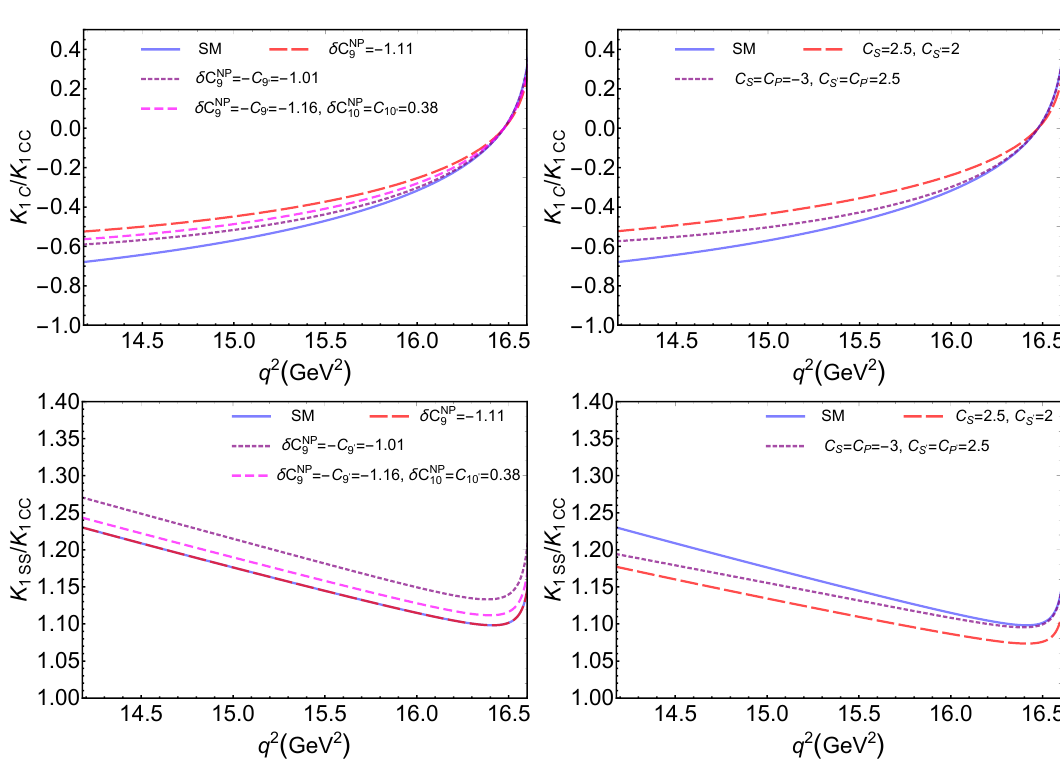
Figure 4 . The ratios K 1 c =K 1 cc and K 1 ss =K 1 cc of (cid:3) b ! (cid:3) (cid:3) ( ! N (cid:22) K ) (cid:22) + (cid:22) (cid:0) in the SM (blue solid line) and in the NP (dashed colored) at the low-recoil. The (cid:12)gures are for illustrative purpose only (see text for